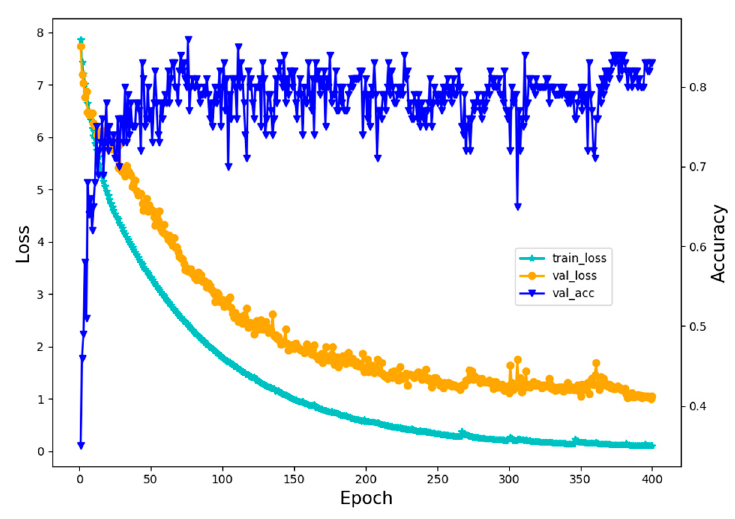
Figure 12. Prediction accuracy and loss function value of the DSCNN model.